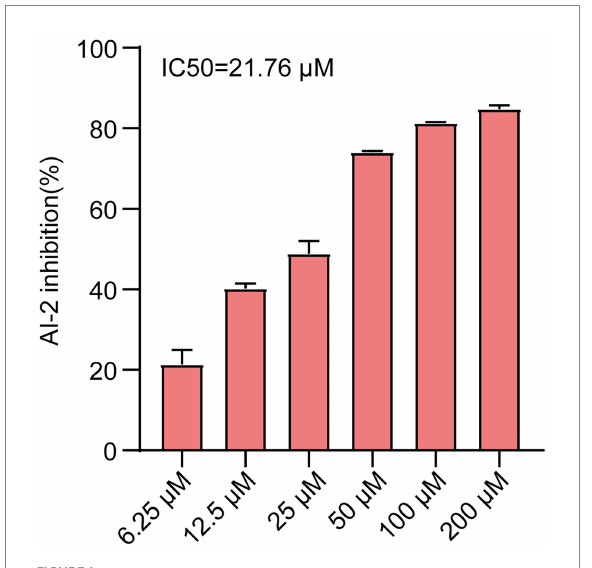
FIGURE 1 AI-2 inhibition of E. coli was treated with various concentrations of Ech (6.25, 12.5, 25, 50, 100, 200 μ M) by AI-2 Bioluminescence assay and IC50 = 21.76 μ M. All experiments were carried out in triplicate, and data represent the mean ± SD.